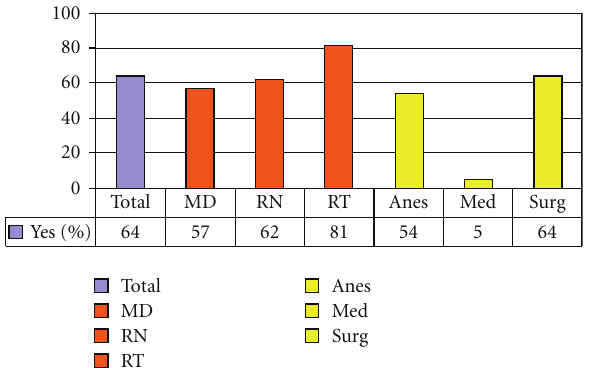
Figure 10: Have had ≥ 1 emergent situations with an altered airway in the last 12